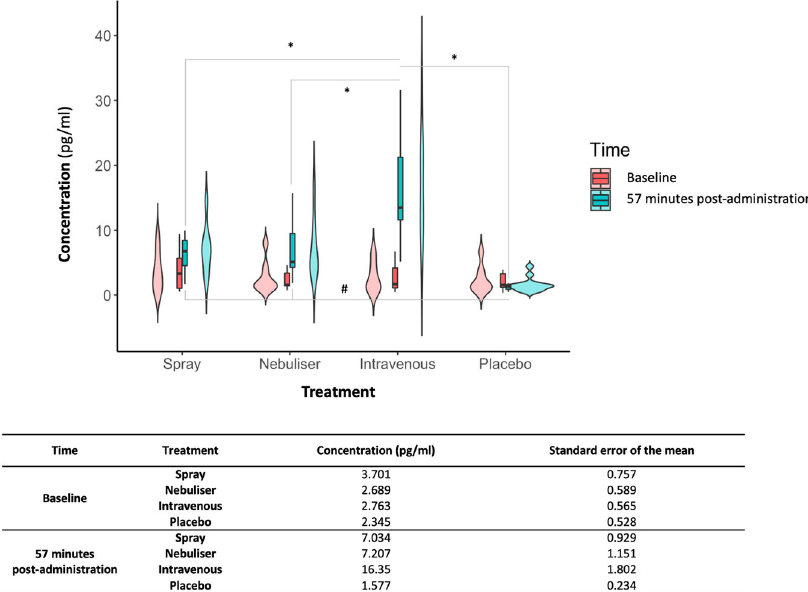
Fig. 7 Baseline and post-administration (57 min from last treatment offset) concentrations of plasmatic oxytocin in each treatment condition. We conducted a linear mixed model on plasmatic oxytocin concentrations measured in a blood sample collected immediately before the beginning of the resting-state acquisition, using Time, Treatment and Time × Treatment as fi xed factors and a random intercept for subject. We followed up the signi fi cant interaction with further post-hoc tests to examine differences between each pair of treatment conditions between baseline and post-administration and between treatment conditions within each time level, using Tukey ’ s correction for multiple testing. In the upper panel, we present box and violin plots depicting the distribution of plasmatic concentrations of oxytocin for each treatment condition and time point; middle horizontal lines represent the mean; boxes indicate the 25th and 75th percentiles ( n = 16 per treatment condition and time point). In the lower panel, we present the descriptive statistics for each level of the two factors. *Intravenous condition compared to the other three ( p < 0.01) at post-administration; # Spray and Nebuliser conditions compared to placebo (<0.001) at